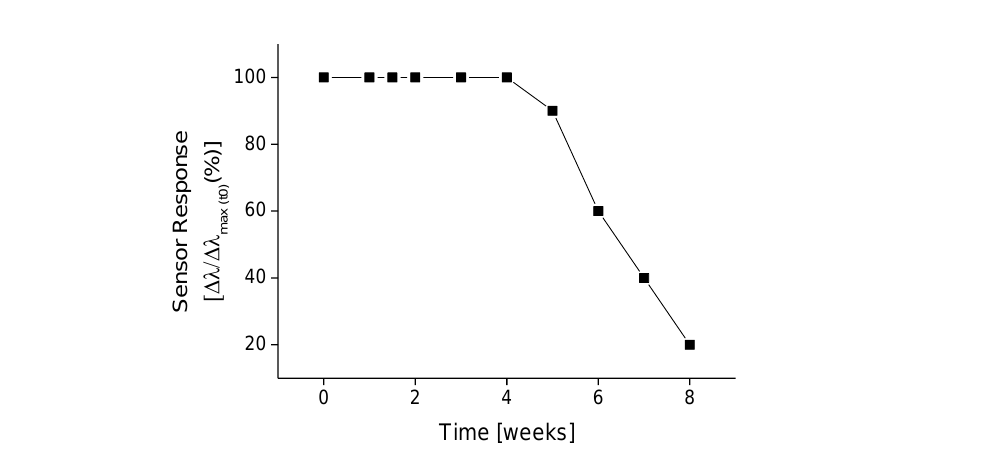
Figure 9. Sensor response (%) during the time. Resonance wavelength variation (Δλ) normalized to the maximal response obtained at the first use (Δλ max(t0) ) as a function of time during the binding and regeneration step.